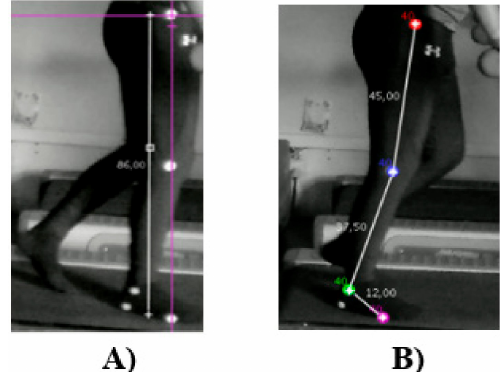
Figure 3. ( A ) Calibration lengths between the hip and sole. ( B ) Calibration lengths between the hip, knee, ankle, and toe.